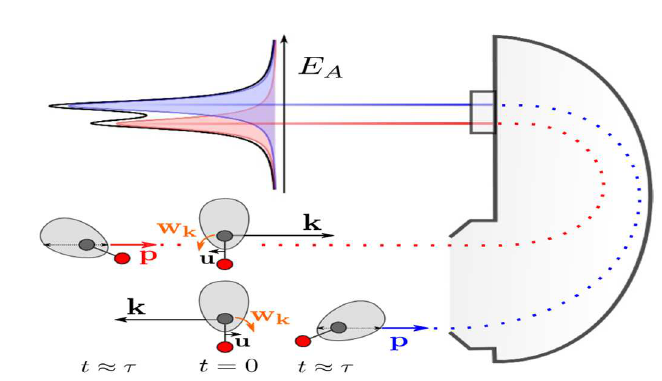
Fig. 5. Classical picture of the dynamical rotational Doppler effect of the C1s core-ionized CO